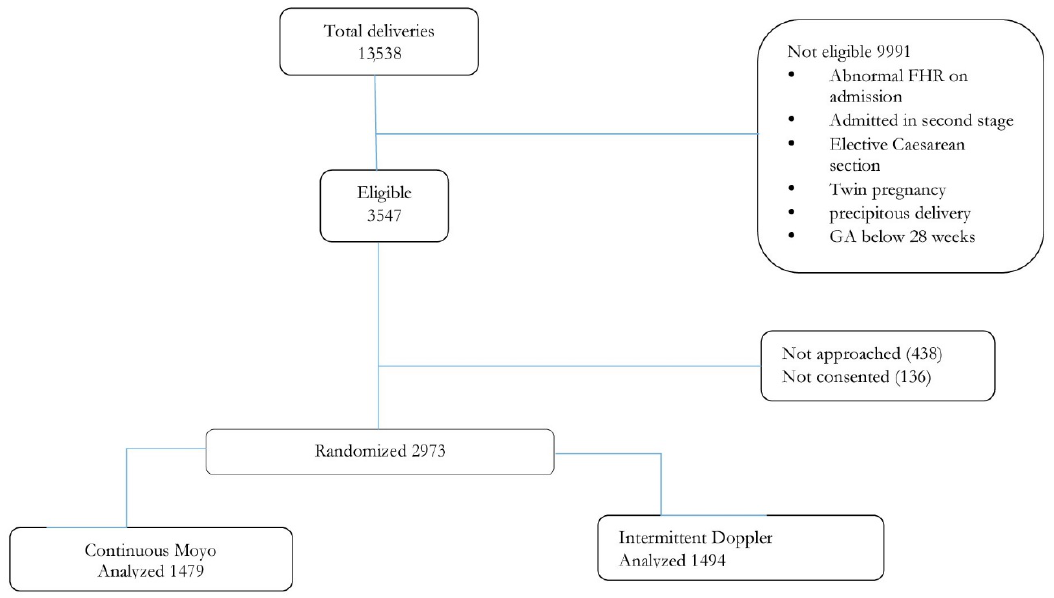
Figure 3. Trial profile.